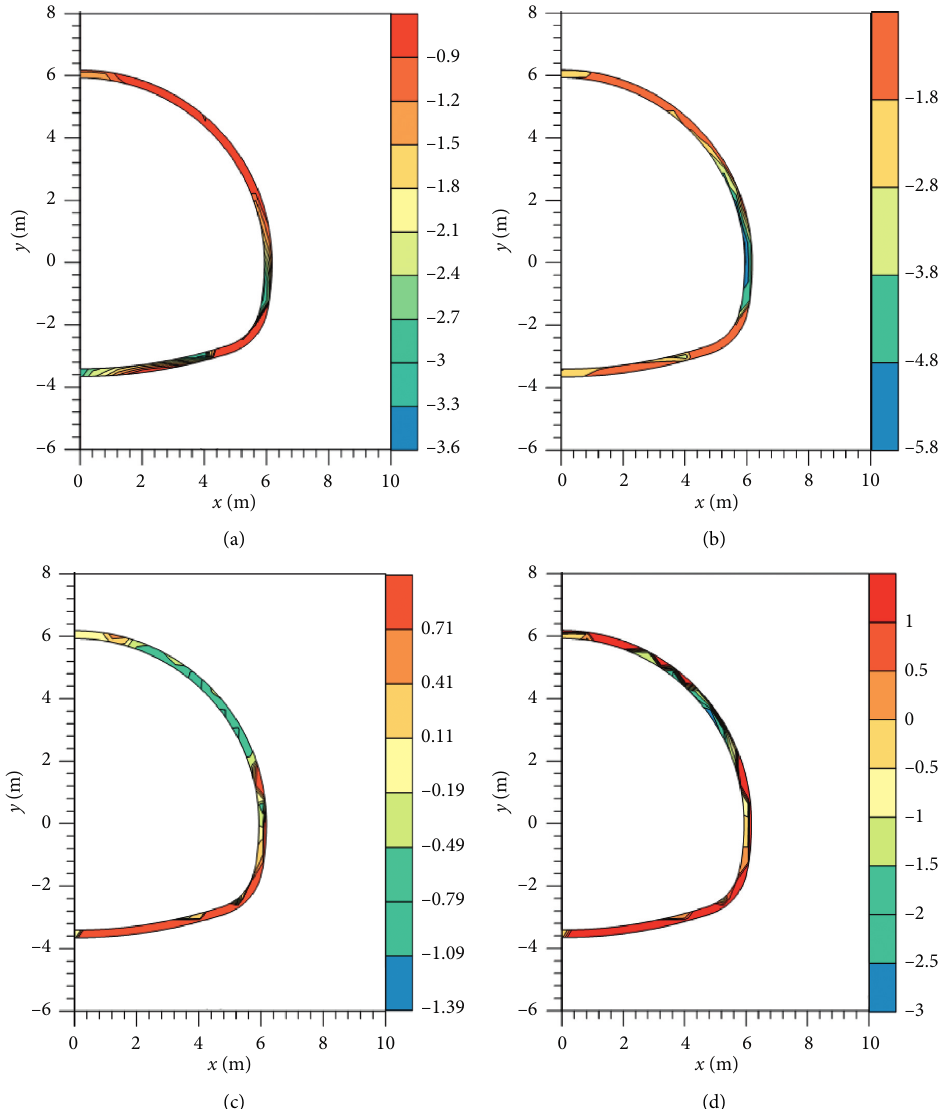
Figure 9: Stress regimes of the primary lining structure at D1 on April 15 in 5 years of the operation period of the tunnel. (a) MAPS in STIL. (b) MAPS in WTIL. (c) MIPS in STIL. (d) MIPS in